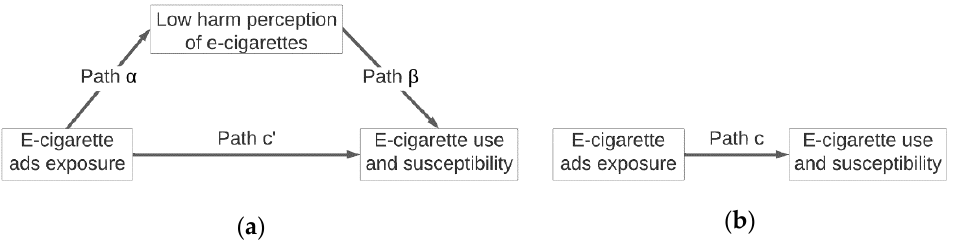
Figure 1. ( a ) Path diagram illustrating the mediating role of e-cigarette harm perception on the relationship between e-cigarette advertising exposure and e-cigarette ever use and susceptibility. ( b ) Total effect accounting for the relationship between e-cigarette advertising exposure and e-cigarette ever use and susceptibility.